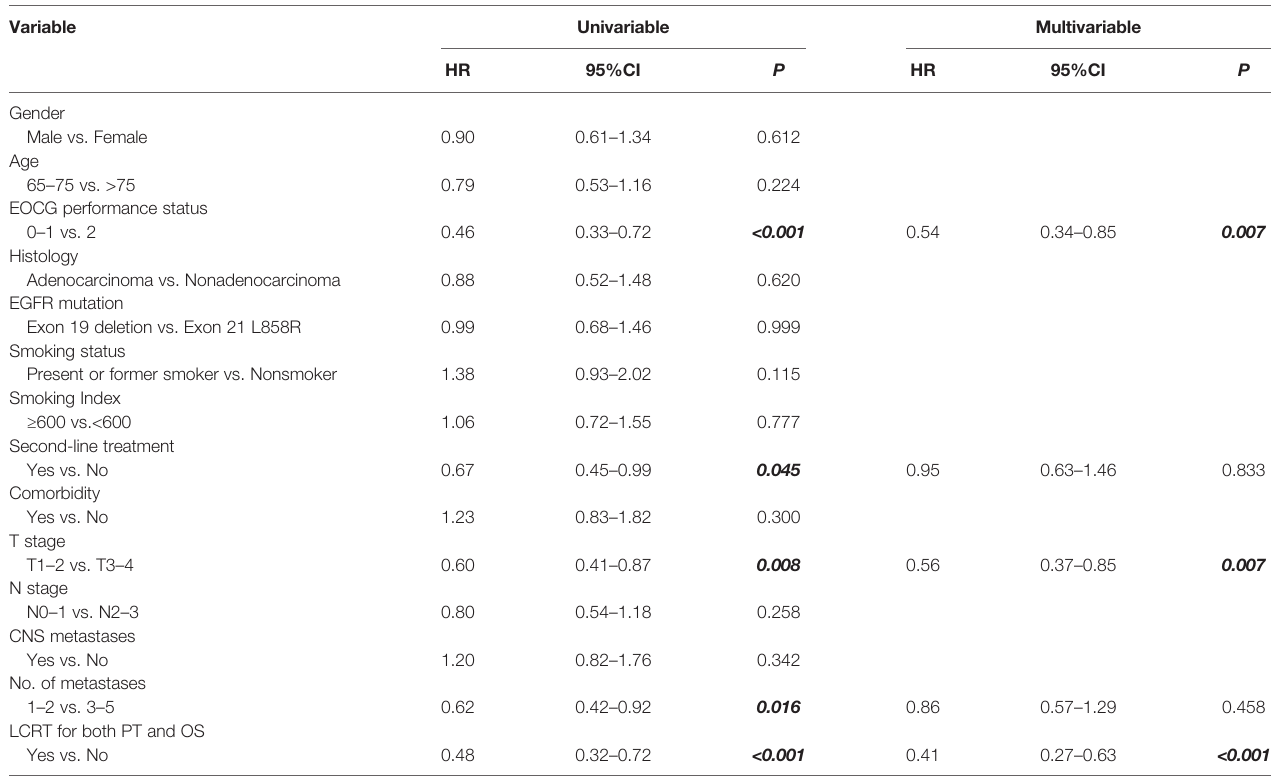
TABLE 5 | Factors associated with overall survival in univariate and multivariate